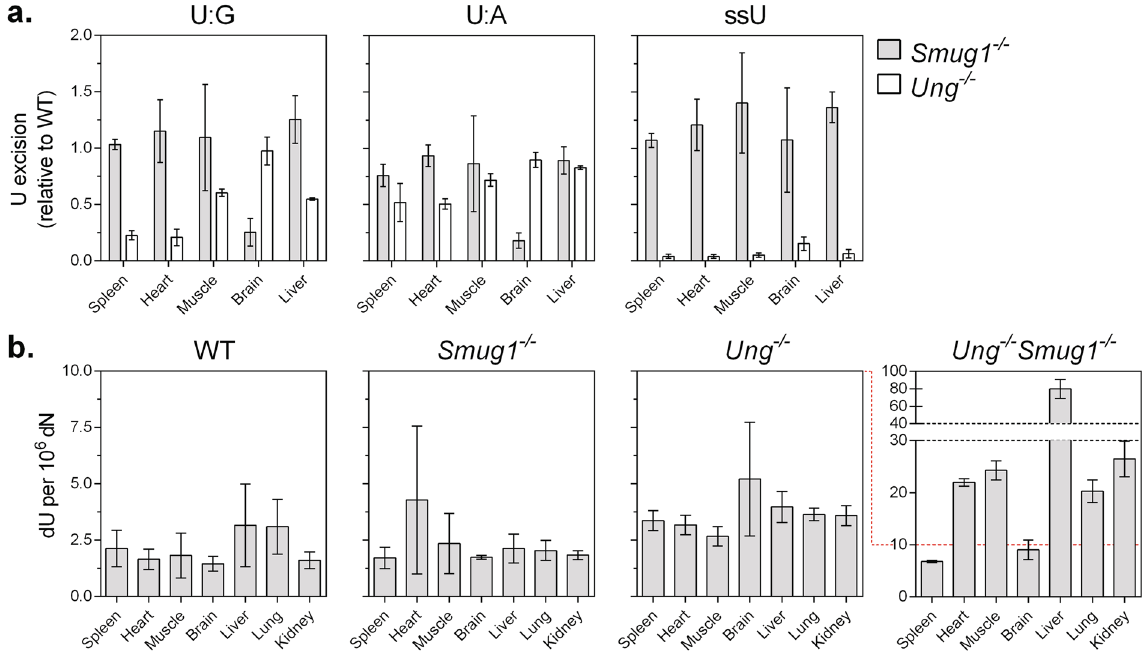
Figure 2. UNG and SMUG1 complement each other in U excision and UNG/SMUG1 double knockout mice accumulate a large amount of genomic uracil. ( a ) Uracil excision activity of Ung − / − and Smug1 − / − organ extracts relative to WT in U:G, U:A, and single-stranded oligonucleotides. Biochemical assays were evaluated using two- tailed t-test 95% confidence level. ( b ) There was no significant genomic dU accumulation in organs from either Smug1 + / − or Smug1 − / − mice. Genomic dU increased slightly in Ung − / − and drastically in Ung − / − Smug1 − / − mouse organs, respectively. The effect of SMUG1 and UNG knockout on genomic lesion levels were assessed using an unpaired t-test or analysis of variance (ANOVA). Error bars indicate SD of three biological